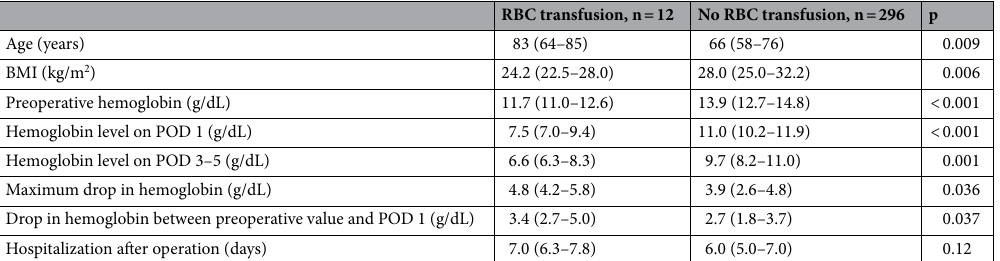
Table 3. Factors influencing red blood cell (RBC) transfusions. Values are given as median (interquartile range). POD postoperative